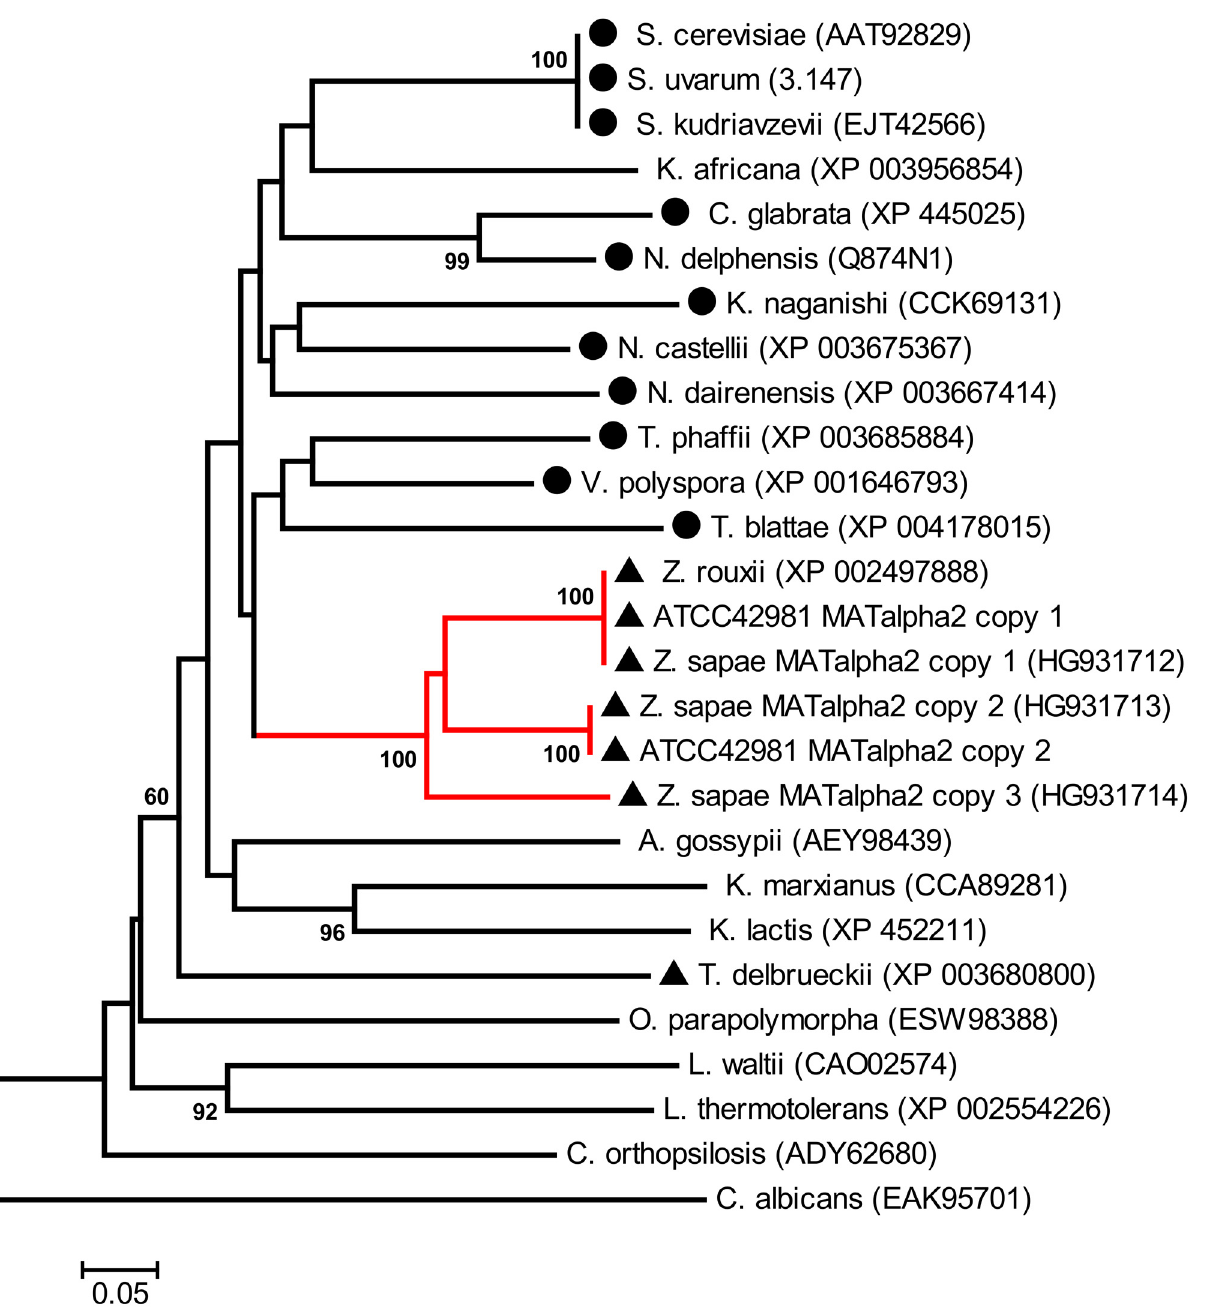
Fig 2. Phylogenetic analysis of MAT α 2 proteins. The neighbour-joining (NJ) tree shows the phylogenetic relationships between the allodiploid strain ATCC 42981 and other hemiascomycetes inferred from MAT α 2 proteins. Numbers on branches indicate bootstrap support percentages (1,000 pseudoreplicates) higher than 60% from NJ. The red branch indicates Z . rouxii complex, which includes Z . rouxii MAT α 2, ATCC 42981 MAT α 2 copies 1 and 2, and Z . sapae MAT α 2 copies 1 to 3 sequences. The dark dot indicates WGD species, whereas the dark triangle indicates non-WGD species with the HO